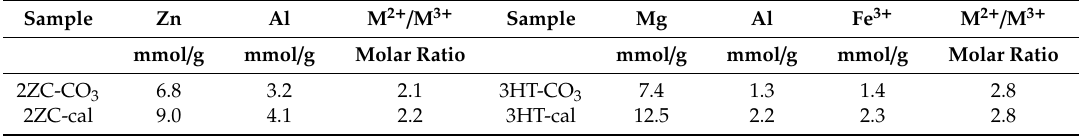
Chemical composition of synthetic untreated carbonate (-CO 3 ) and calcined (-cal) hydrotalcite-like (3HT) and zaccagnaite-like (2ZC)